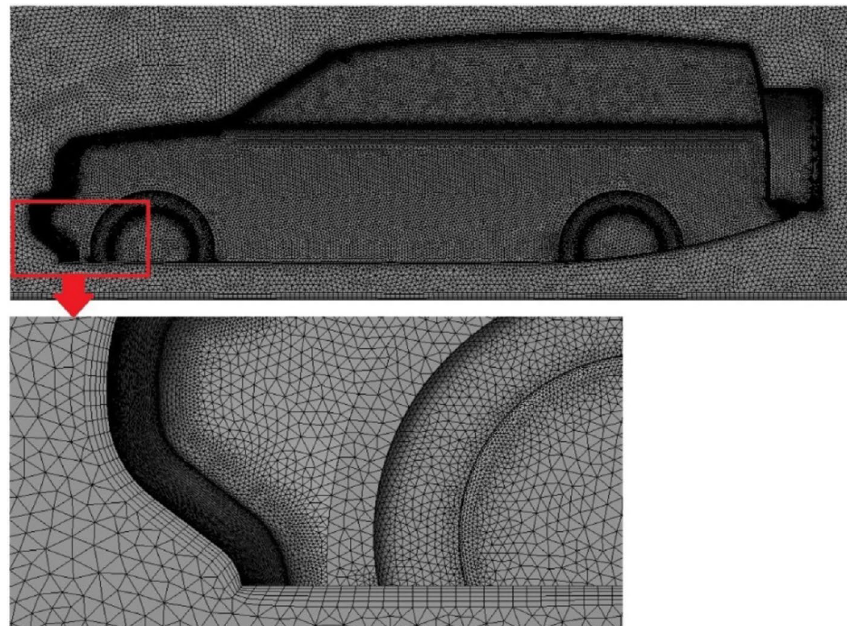
Figure 6. Mesh of the modified LRD4 with a close-up at the front bumper.